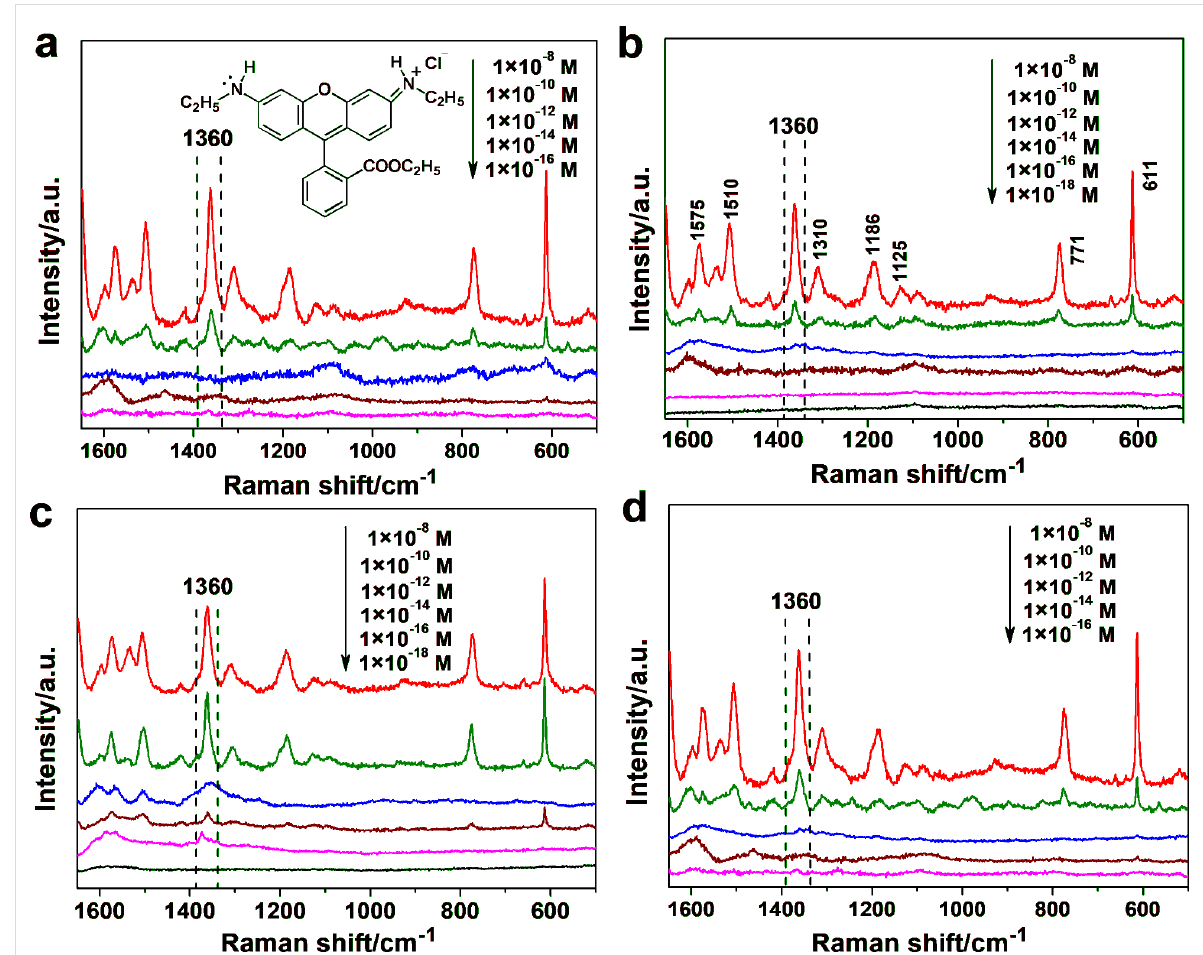
Figure 4: SERS spectra of Rhodamine 6G (R6G) at different concentrations obtained by employing Ag-NP/cellulose-NF–A (a), –B (b), –C (c), and –D (d) composite sheets as the substrates. The characteristic band at 1360 cm − 1 was used as the reference, and the SERS measurements were acquired from four randomly selected locations on each of the samples. The inset of (a) is the molecular structure of R6G.